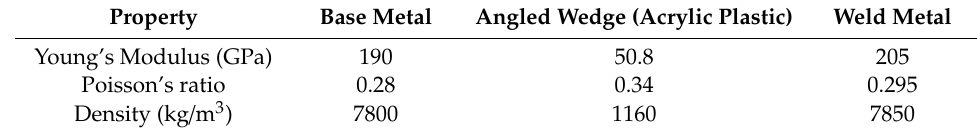
Table 3. Materials’ properties (based on ASTM A1008 / A1008M [21]) used in the numerical